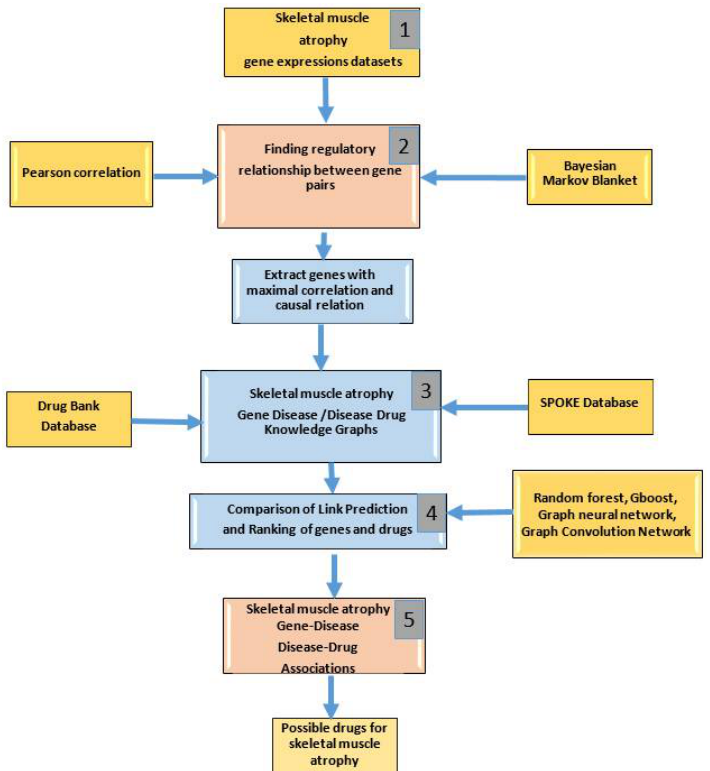
Figure 1. Workflow pipeline showing the order of steps involved in constructing GDKG and DDKG and link prediction methods for finding key diseases associated with skeletal muscle atrophy genes and drugs for